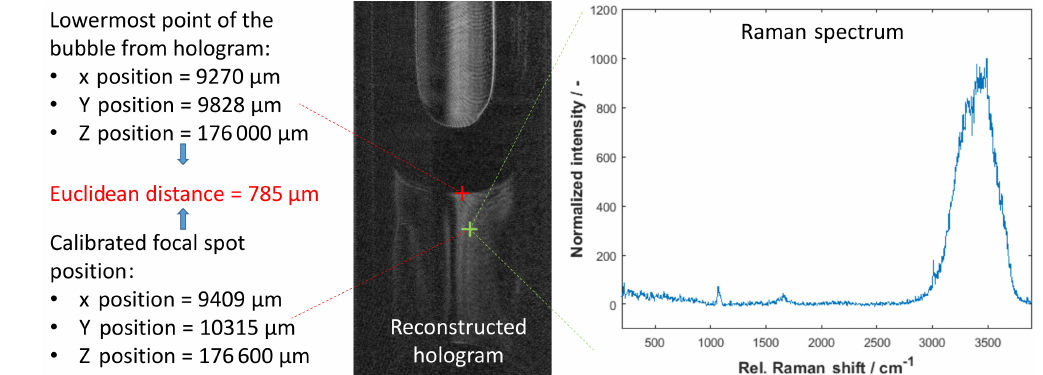
Figure 10. The experimental results of the simultaneous bubble position measurement and localised concentration measurement of CO 2 absorption in caustic